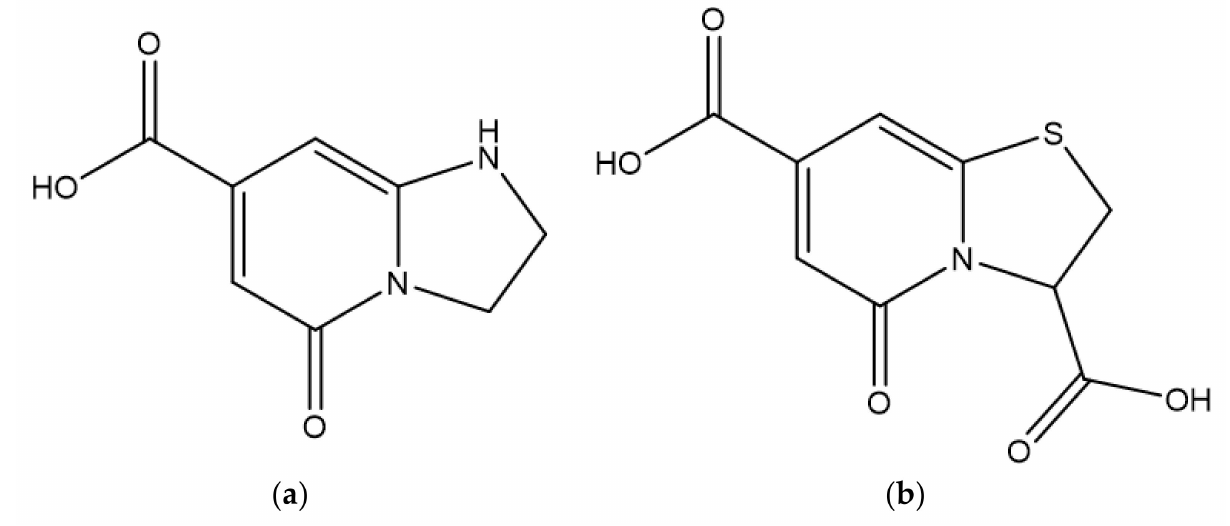
Figure 1. Chemical structures of IPCA ( a ) and TPDCA ( b